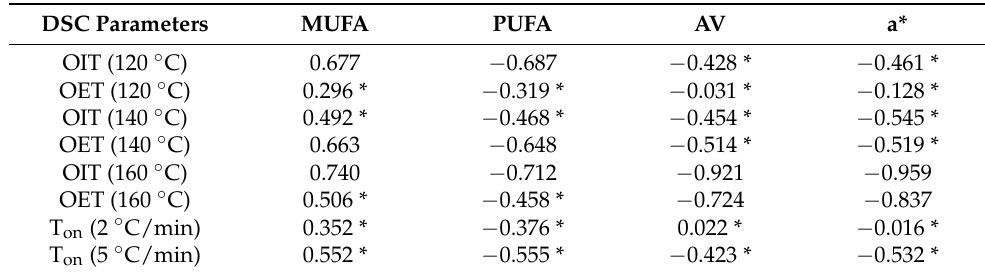
Table 7. Pearson’s correlation coefficients between DSC oxidation parameters and MUFA, PUFA, AV, and a*